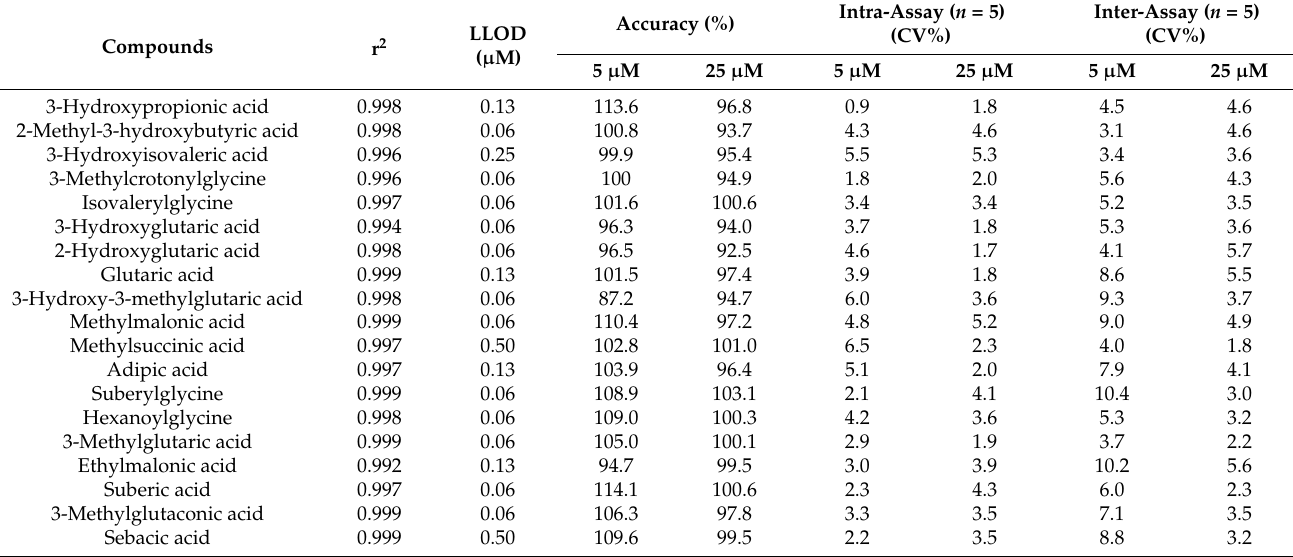
Table 2. Result of validation study. r 2 : correlation coefficient of the calibration curves ranging 2 – 100 µM. LLOD: Low limit of detection. LLOQ: Low limit of quantification.